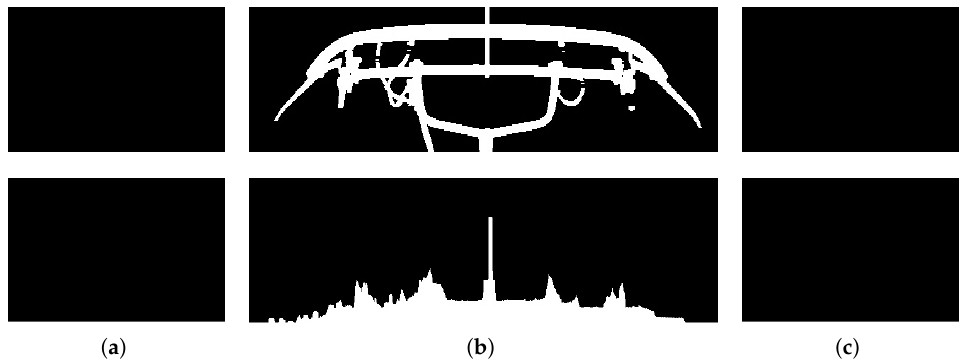
Figure 21. Binary image of different regions and the corresponding vertical projections after the opening operation. ( a ) L-ROI. ( b ) ROI. ( c ) R-ROI.